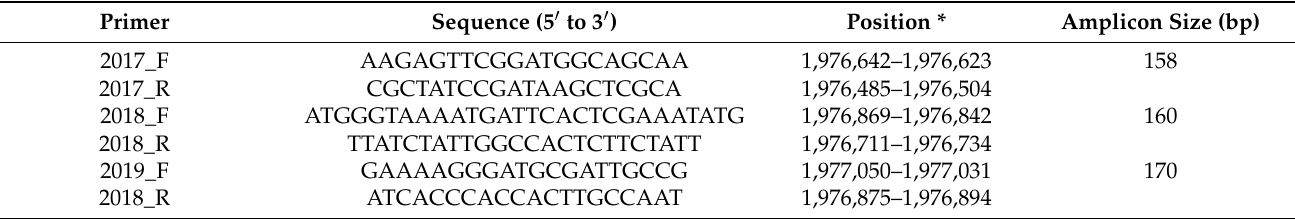
Table 2. The list of primer sequences for strain-specific